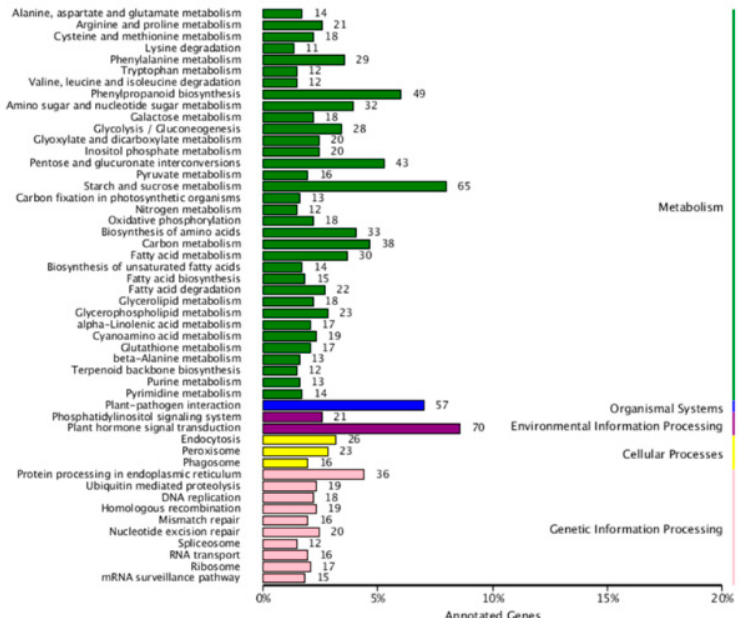
Figure 6. KEGG pathway enrichment analysis of the differentially expressed mRNAs identified in Bcpol97-05A (sterile line) compared to Bcajh97-01B (fertile line) of Brassica campestris .